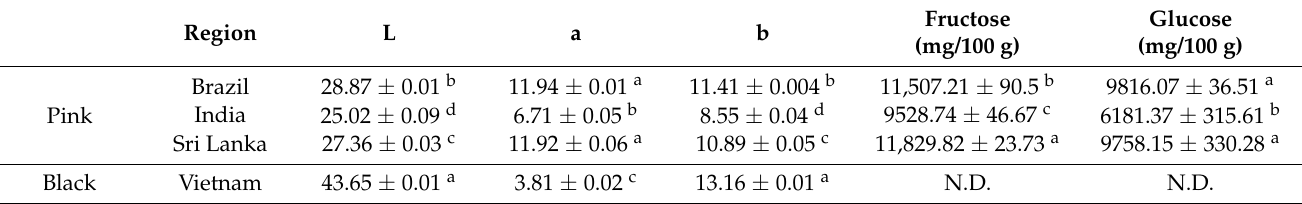
Table 1. Color and sugar composition of pink and black